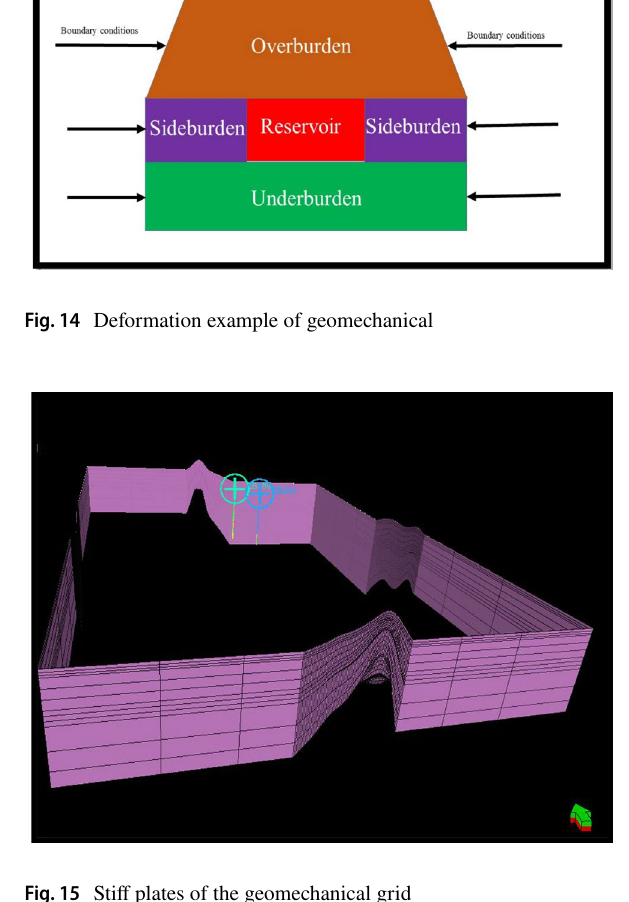
Fig. 15 Stiff plates of the geomechanical